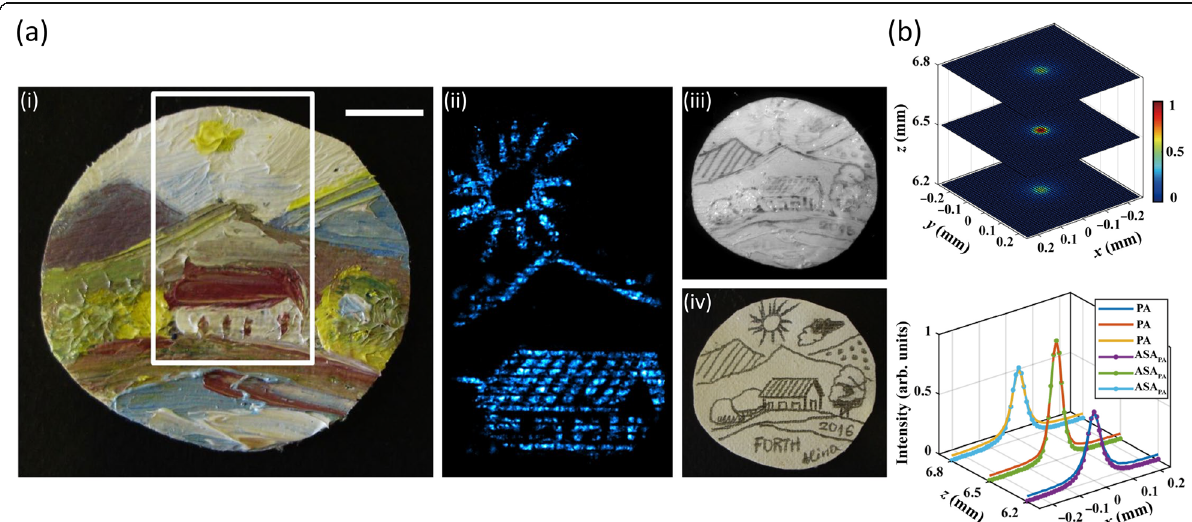
Fig. 6 Representative applications of other materials using PA technologies for NDT/E. ( a ): PA detection of underdrawings in paintings [40]. (i) Brightfield view of the painting (rural landscape), (ii) PA image of the underlying sketch of the painting over a region indicated by the white box in (i), (iii) NIR image of the underdrawing at 1200 nm, and (iv) Brightfield view of the original pencil sketch before overpainting. Scale bar = 1 cm; ( b ): SIR measurement of ultrasound transducers using PA method [51]. 2D acoustic intensity profile of a 93 MHz focused transducer on x - y plane at z = 6.2, 6.5, and 6.8 mm (top). Comparison of the PA-measured and calculated results (bottom), showing good agreement. The PA-measured results mean the acoustic intensity distribution measured by the PA method (denoted as “ PA ” in the legend); the calculated results mean the acoustic intensity distribution calculated by the angular spectrum approach (ASA) based on PA-measured SIR (denoted as “ ASA PA ” in the legend)